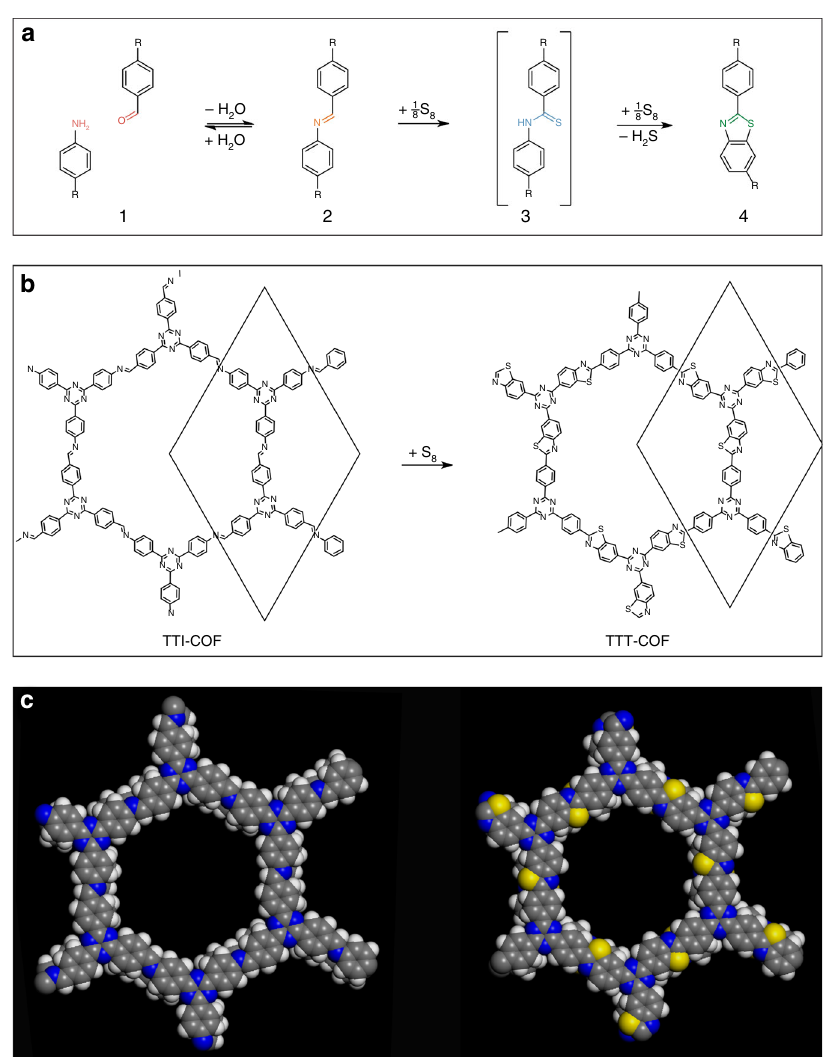
Fig. 1 Schematic of the imine to thiazole transformation in the TTI-COF. a Schematic of the reaction of an amine and an aldehyde (1) to form an imine (2), then a thioamide as an intermediate (3) by the action of elemental sulfur, and fi nally a thiazole (4). b Schematic drawing of the sulfurization reaction of the TTI-COF to form the thiazole-based TTT-COF. c Space fi lling model of one pore of the TTI-COF (left) and the TTT-COF